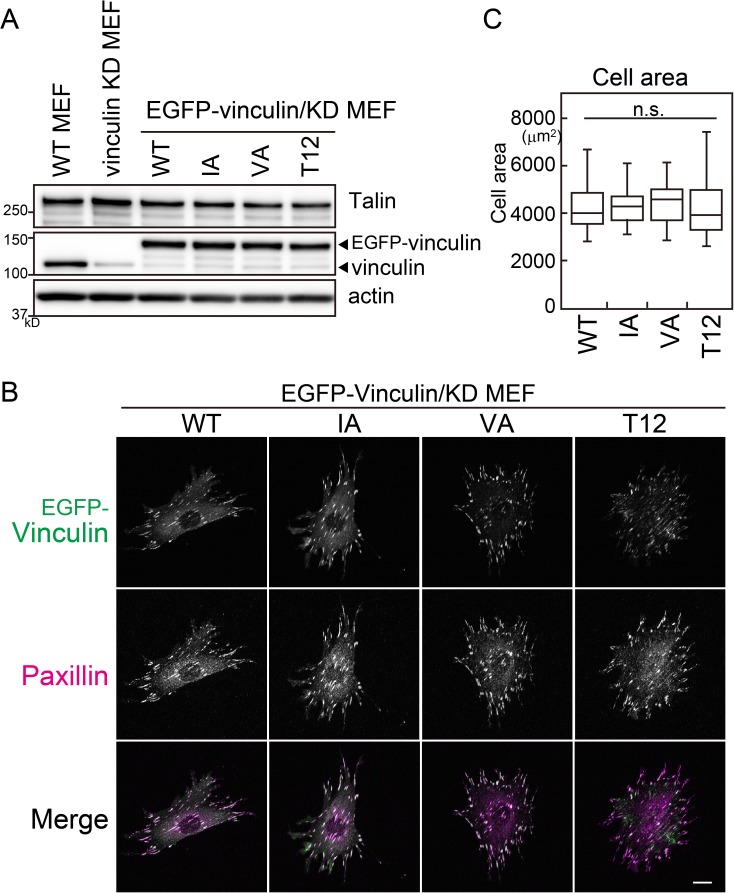
Expression levels and subcellular localization of vinculin mutants.(A) Expression levels of endogenous and GFP-tagged vinculin. Cell lysates were isolated from WT cells, vinculin KD cells, or vinculin KD cells expressing GFP-tagged vinculins. Talin and β-actin were used as loading controls. (B) Immunofluorescence analysis of cells expressing each mutant using the indicated antibodies. Scale bar: 20 μm. Fifty individual cells from two separate experiments were photographed for each condition. (C) Cell area. The values represent the means ± S.E.M. One-way ANOVA, Scheffe’s test for multiple comparisons (n = 50; n.s., non-significant).